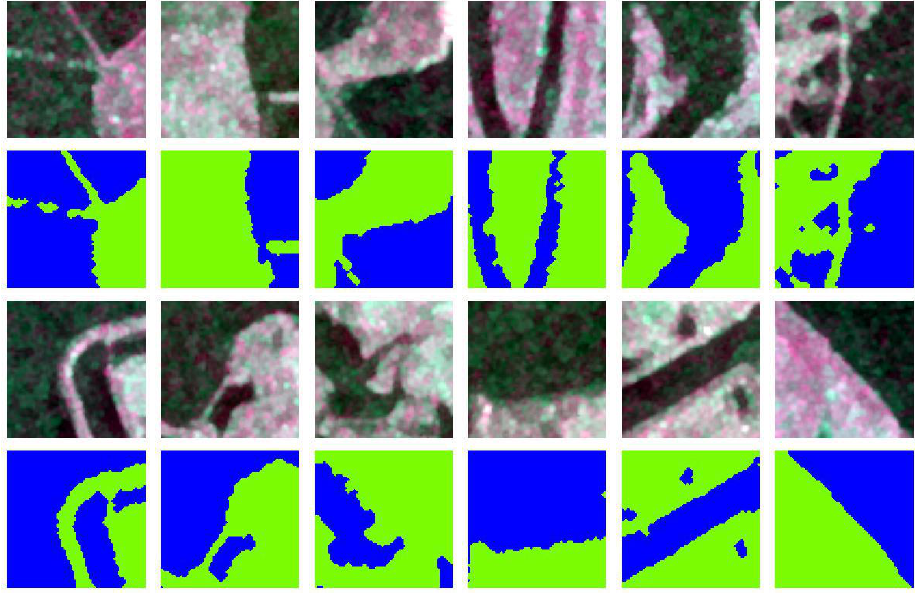
Figure 8. Examples of training data and validation data. Blue: water; green: other land